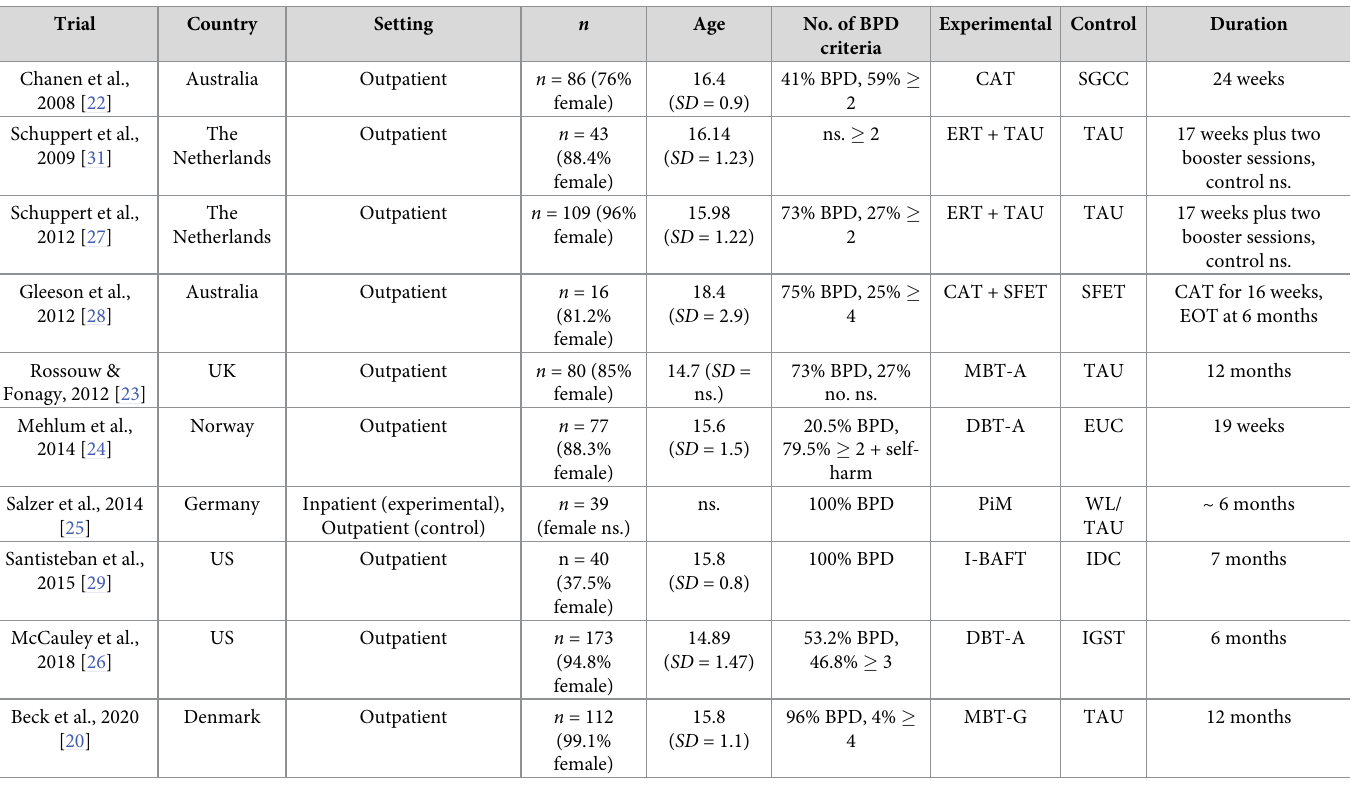
Table 1. Description of included